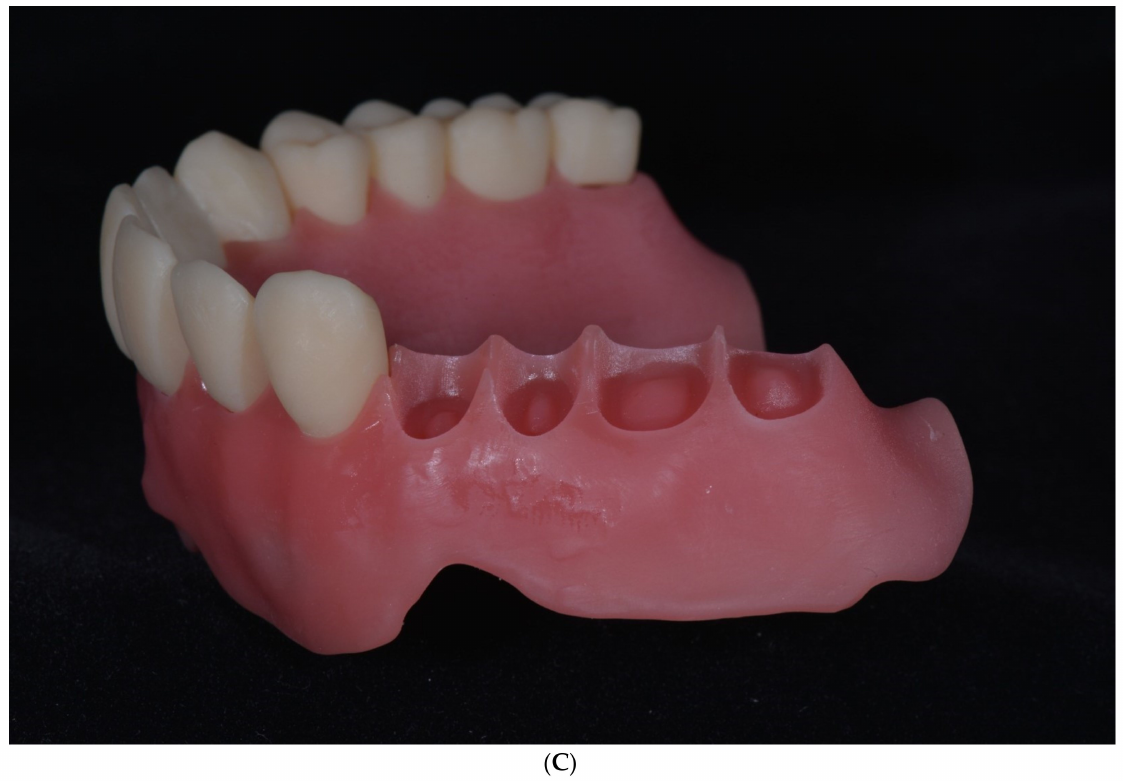
Figure 4. Bonded printed denture. ( A ): Printed denture base. ( B ): Printed artificial teeth. ( C ): Printed artificial teeth are bonded onto the printed denture